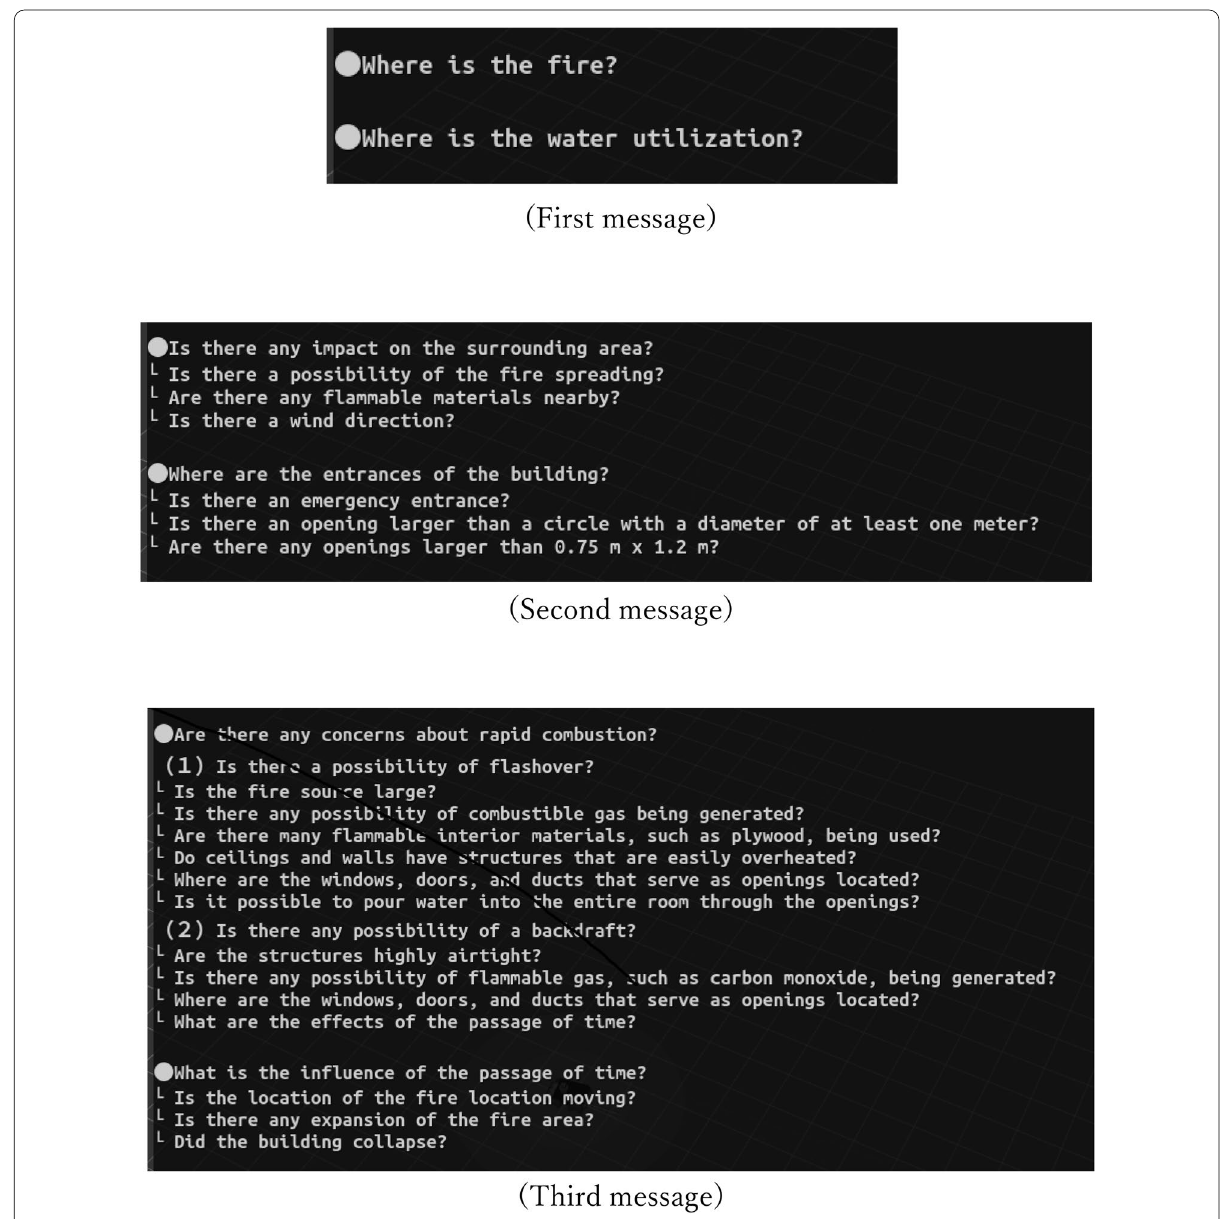
Fig. 8 Switching the work support messages for type I and the reconnaissance